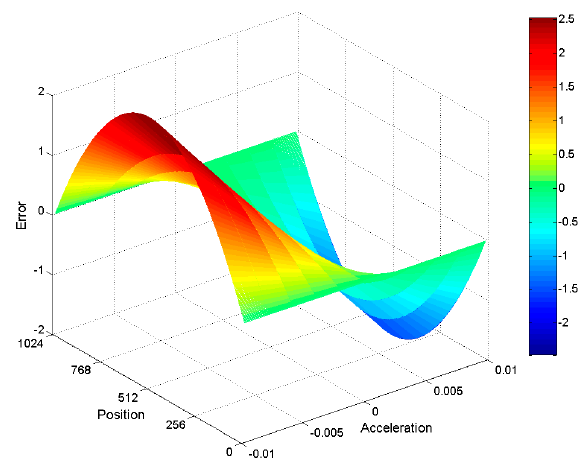
Figure 4. Subdivision error using unequal interval sampling.